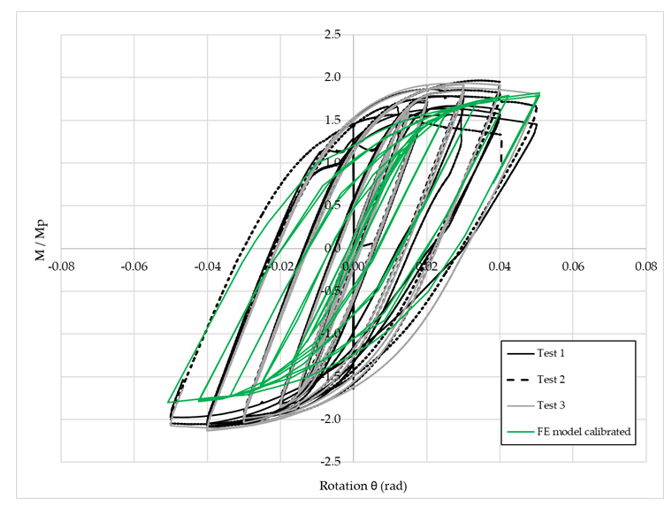
Figure 8. Model in FE calibrated according to [12]. Note: Mp = Fy.Zx , where Mp is the plastic moment of beam connected.